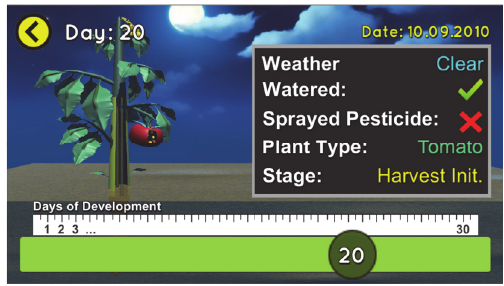
Figure 20: Tracking plant scene.